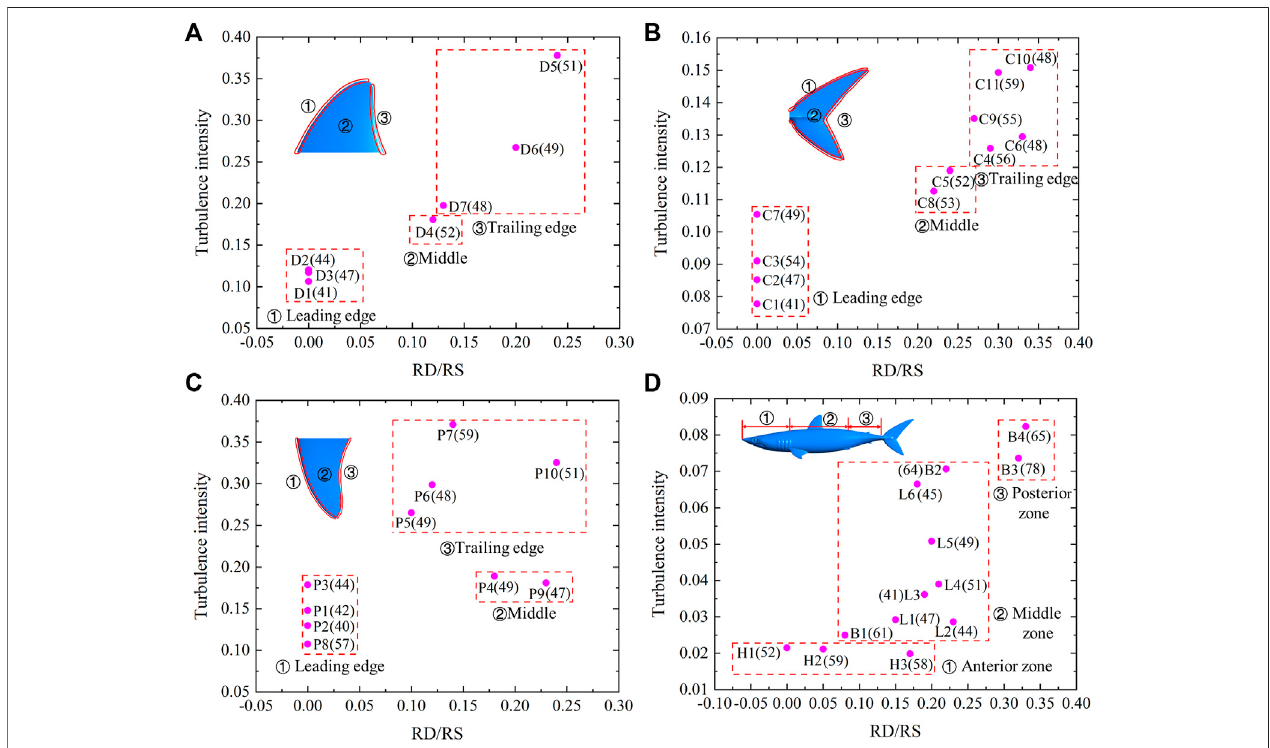
FIGURE 8 | Relationship between the turbulence intensity and riblets RD/RS at y + = 20. (A) First dorsal fi n, (B) Caudal fi n, (C) Pectoral fi n, (D) Shark body. Each pinkdotrepresents anindependentsample.Thenumbers inbracketsindicatethedensity ofsharkskinscales.Theserialnumbersrepresent different areasoftheshark.